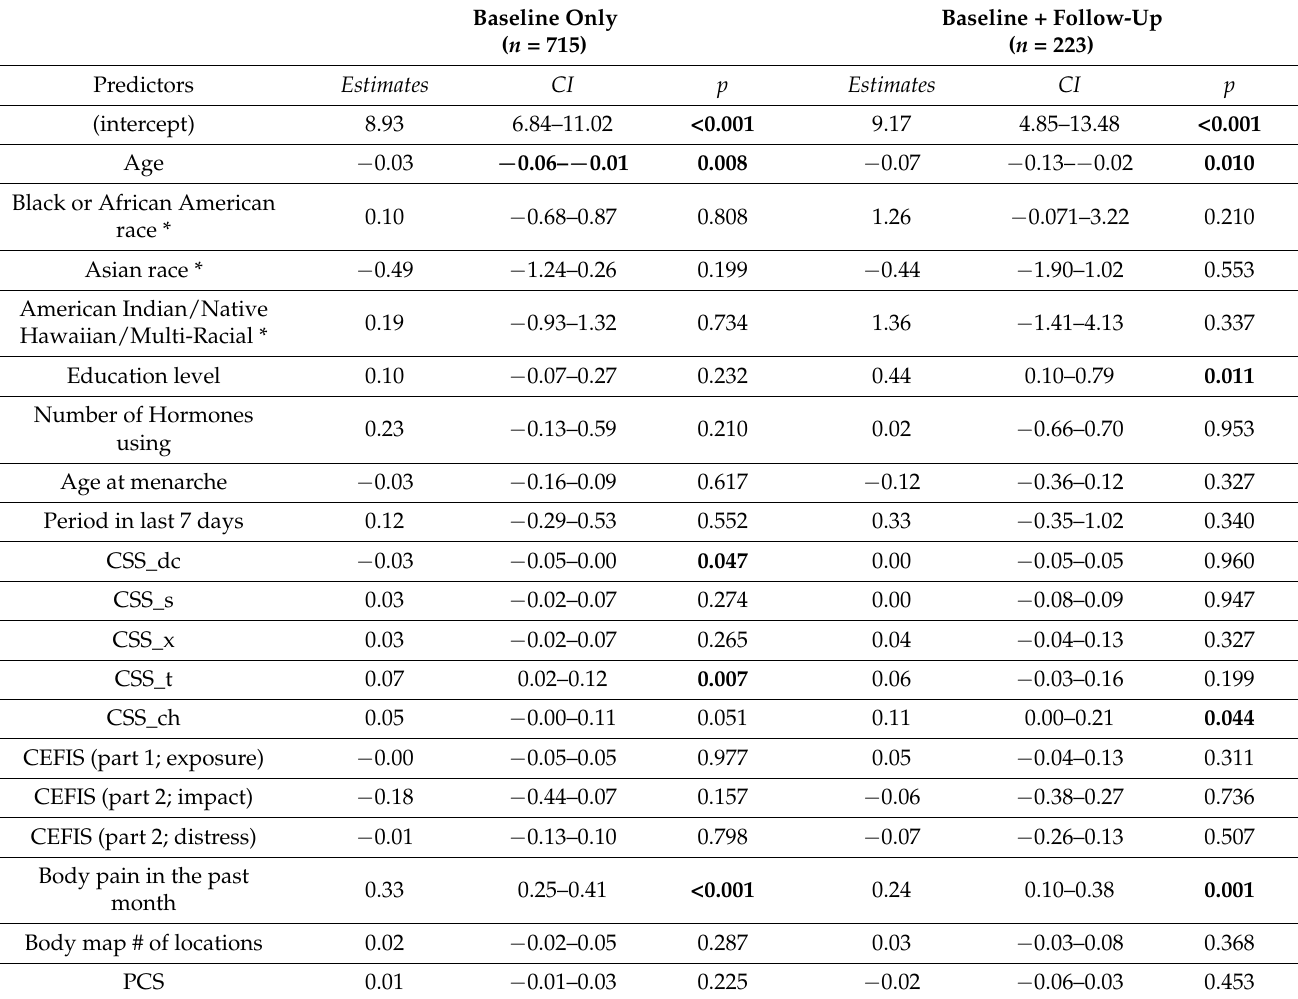
Table 4. Predictors of Menstrual Symptom Count in participants who completed the baseline assessment only and those who completed both baseline and follow-up